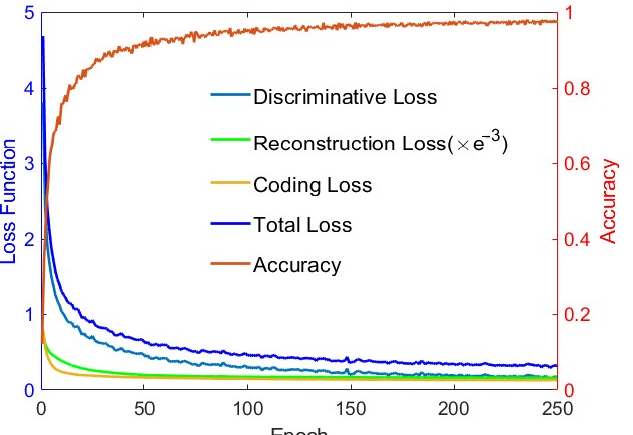
Figure 4. The loss function value of training samples and classification accuracy of the developed model versus the number of